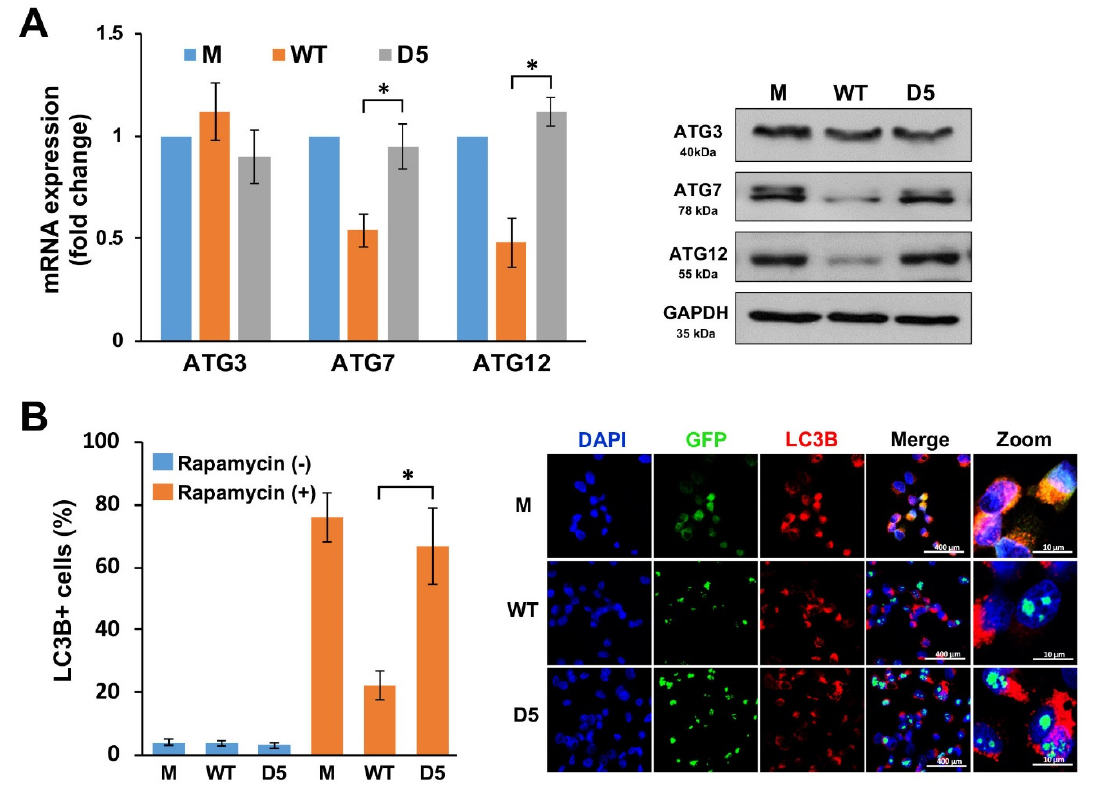
Figure 6. NOP53 reduces ATG7 and ATG12 expressions through interactions with histone H3. ( A ) Mock (M), wild − type NOP53 (WT), and the D5 mutant (D5) were transfected in LN18 cells for 48 h, and then, qPCR (left panel) and Western blotting (right panel) were conducted. Data were obtained from three independent experiments and shown as the means ± SD; * p < 0.01. ( B ) The cells were treated as in “A” with or without rapamycin, and immunocytochemical staining was performed using an anti − LC3B antibody. The histogram reveals the ratio of cells with LC3B − positive cells. Data were obtained from three independent experiments and shown as the means ± SD; * p < 0.01. Representative immunocytochemical images are shown in the right